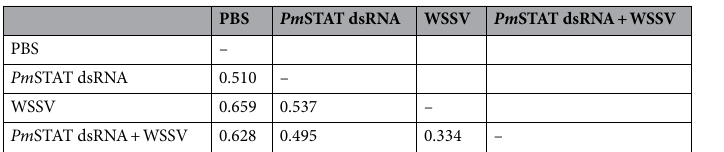
Table 2. Pairwise distance between the centroids for all the treatments.